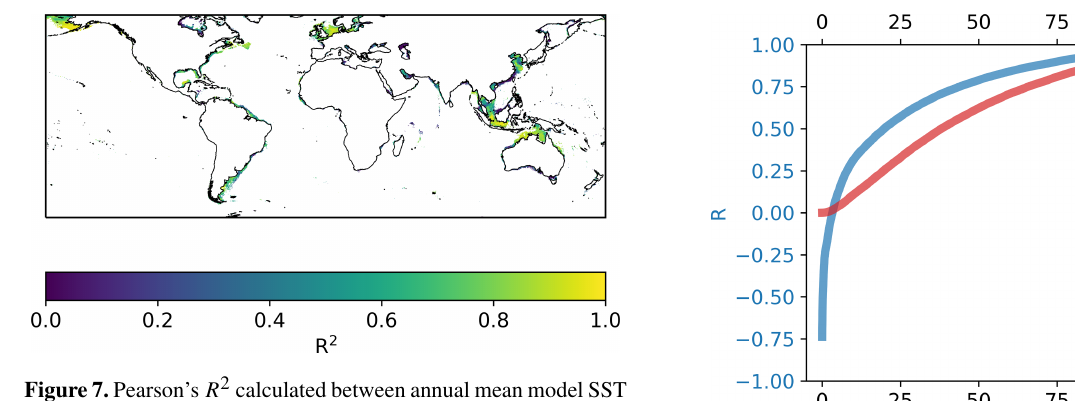
Figure 7. Pearson’s R 2 calculated between annual mean model SST simulation and annual mean satellite SST data (Merchant et al., 2019) between 2006 and 2016.